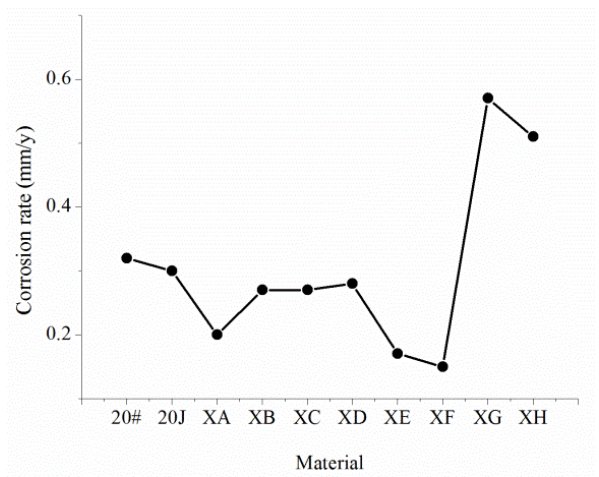
Figure 8. Corrosion rate of different materials.